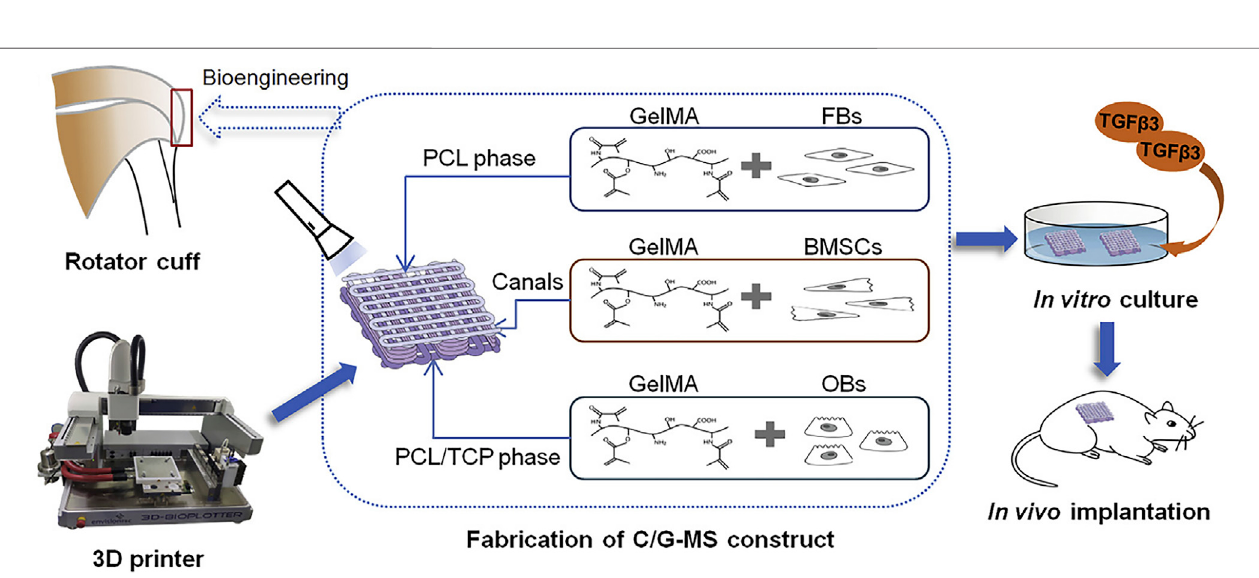
repair under external mechanical force, and the adhesive property increased the stability of material at the tendon- bone interface.